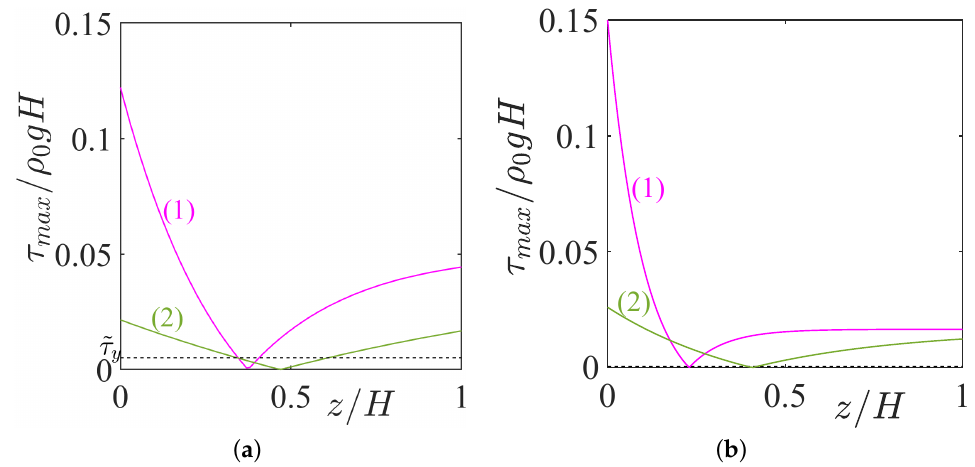
Figure 5. Variation of τ max / ρ 0 gH as a function of z / H . ( a ) Experiments of Kebiche et al. [13] where ˜ τ y = τ y / ρ 0 gH = 5.09 × 10 − 3 : (1) κ = 1.14 × 10 − 3 , Λ = 0.306, Ψ = 0.238, (2) κ = 6.03 × 10 − 3 , Λ = 1.325, Ψ = 1.257. ( b ) Experiments of Darbouli et al. [12]: (1) κ = 8.58 × 10 − 4 , Λ = 9.94 × 10 − 2